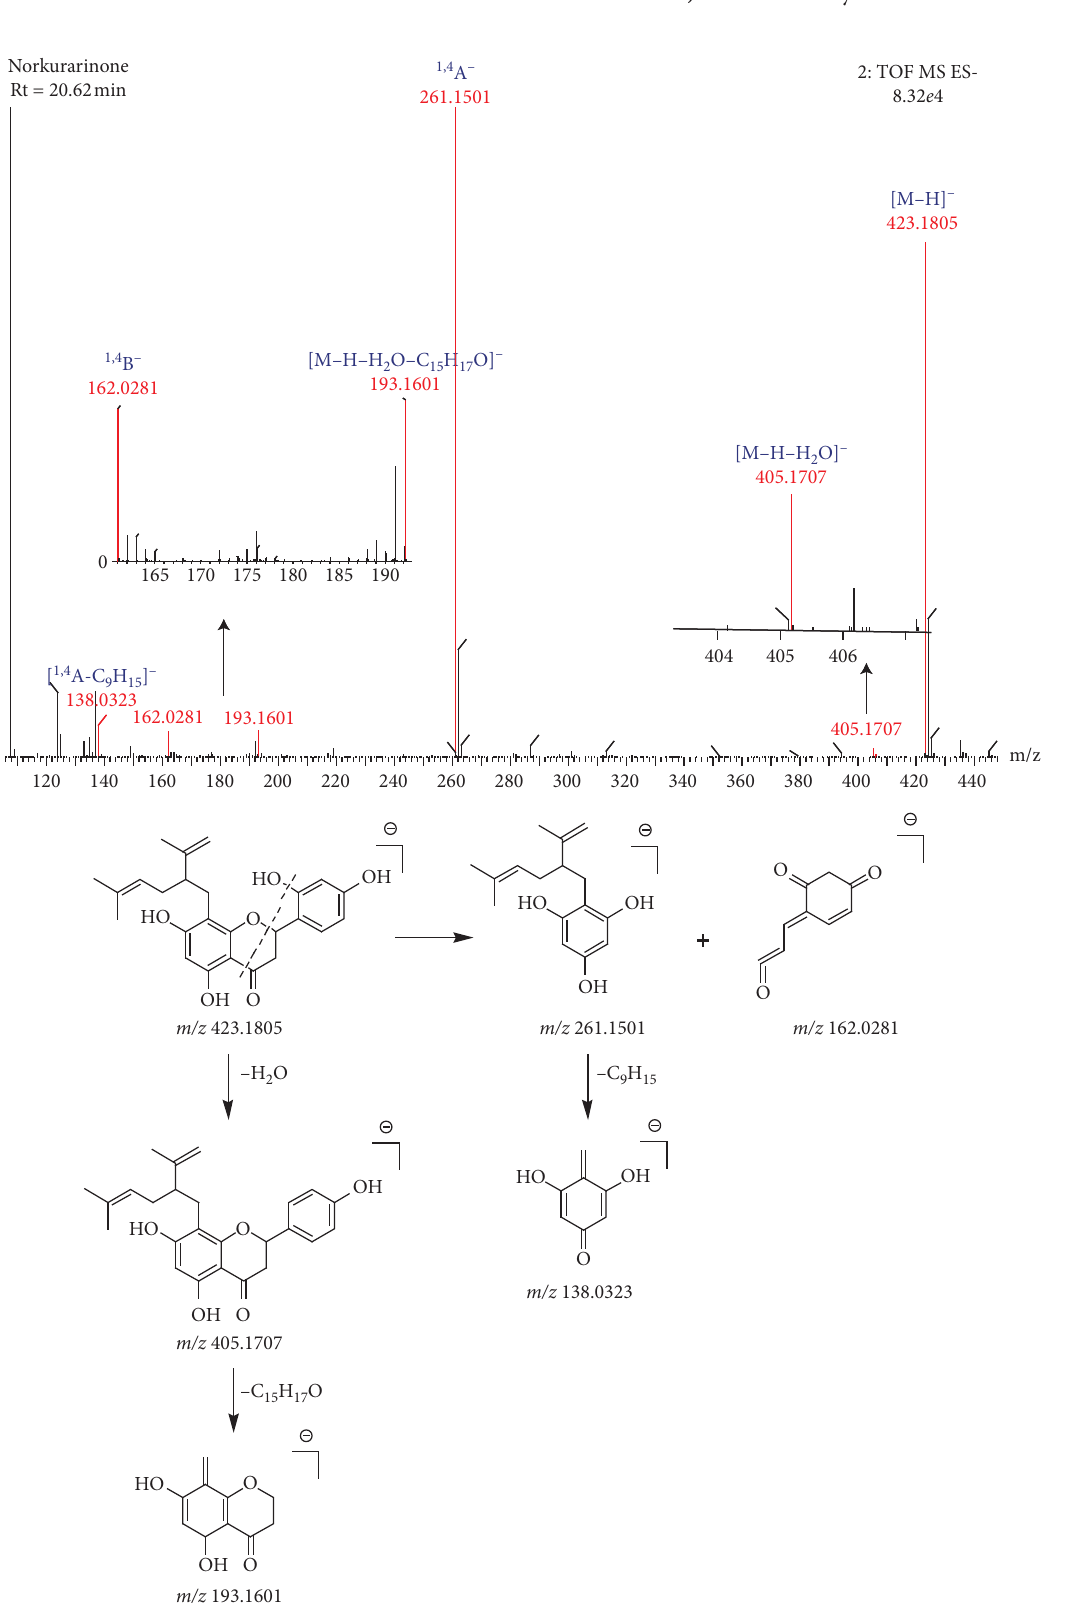
Figure 5: The fragmentation process of norkurarinone in the negative ion